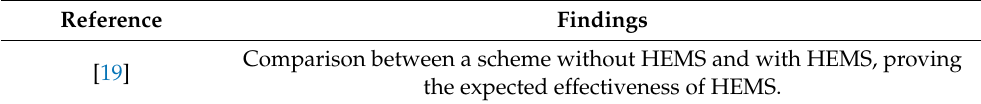
Table 6. Findings of selected papers associated with linear programming.